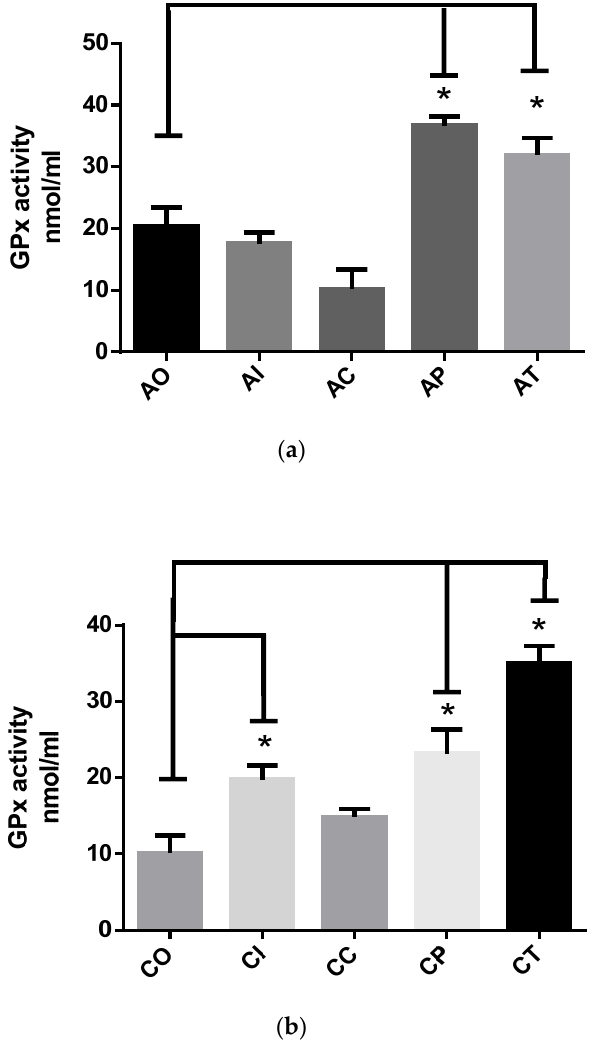
Figure 3. The glutathione peroxidase (GPx) activity in rats exposed to ozone during the acute and chronic phases: ( a ) the preventive administration of dietary curcumin in the preventive approach at the end of the acute phase presented increased activity of GPx (* p < 0.05) when compared to the AO group. Similarly, the AT group showed increased GPx activity ( p < 0.01) compared to the acute ozone-exposed control group OA; acute O 3 (AO), acute intact (AI), acute CUR (AC), acute preventive (AP), acute therapeutic (AT); ( b ) the effect of curcumin in the CP and CT groups (* p < 0.01) resulted significantly increased GPx activity (* p < 0.05) compared to the chronic ozone-exposed control CO group; chronic O 3 (CO), chronic intact (CI), chronic CUR (CC), chronic preventive (CP), chronic therapeutic